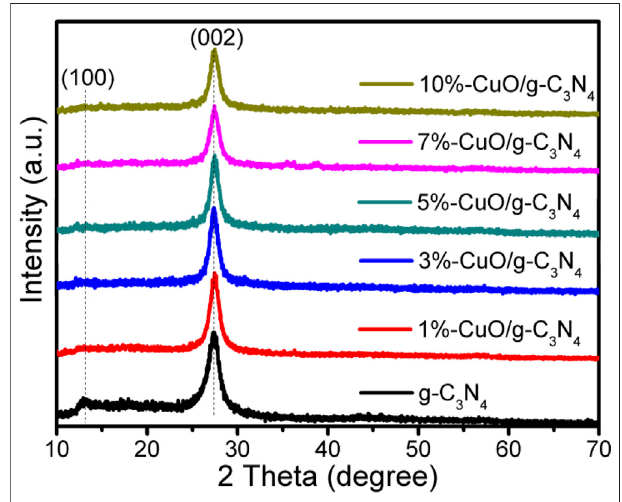
FIGURE 1 | X-ray diffraction (XRD) patterns of graphitic carbon nitride (g-C 3 N 4 ) and CuO/g-C 3 N 4